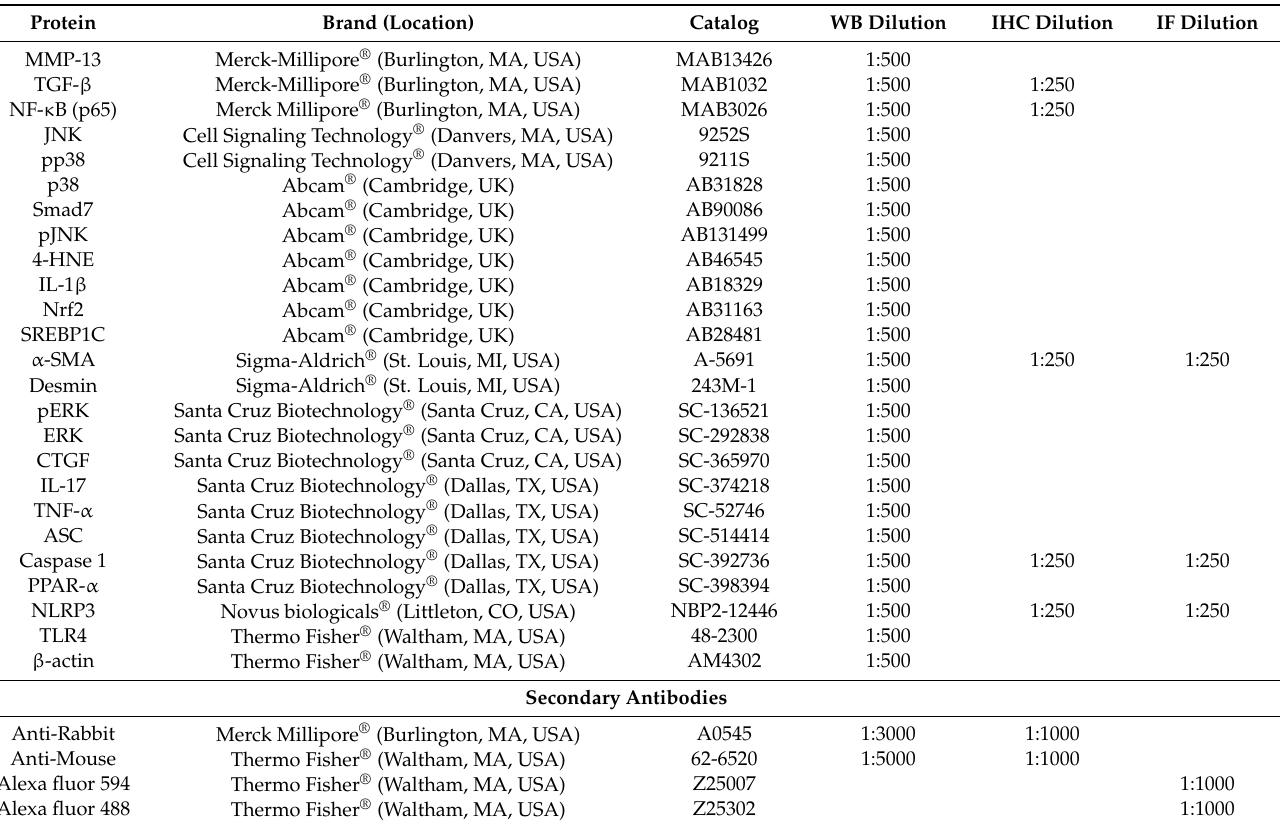
Table 1. Antibodies used in western blot, immunohistochemistry and immunofluorescence techniques. Protein Brand